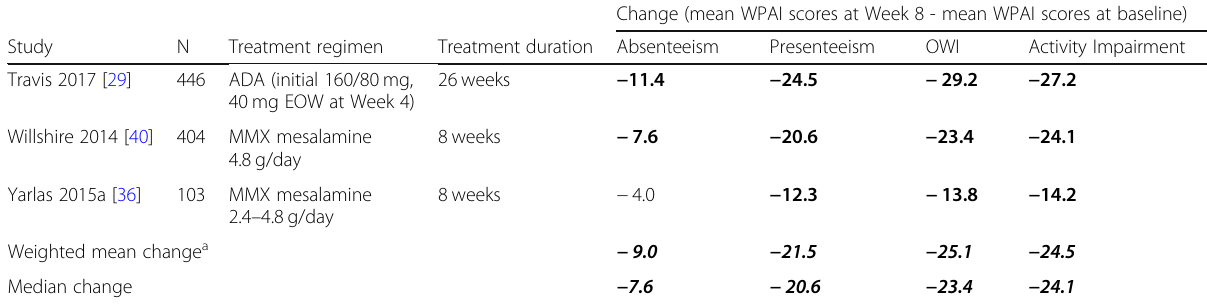
Table 7 Responsiveness to treatment: change in WPAI scores following effective treatment interventions in prospective, open-label